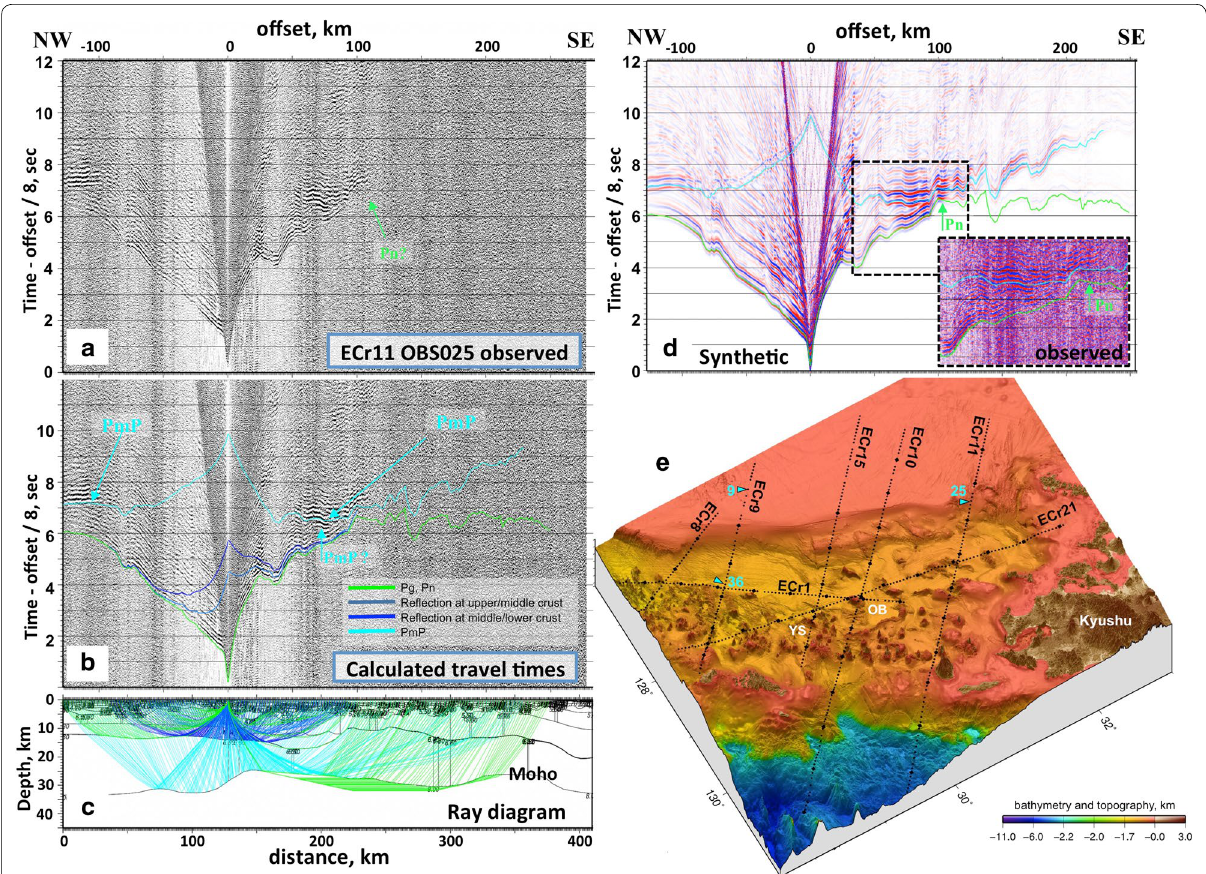
Fig. 7 Example of forward modeling for OBS025 on ECr11. a Observed record section, b calculated travel times on the record section, c ray diagram, d synthetic record sections with calculated travel times. Blowups of the observed weak Pn signals are also shown. Predictive deconvolution, 4–20 Hz bandpass filter, and a gain factor proportional to distance were used to increase signal-to-noise ratios of the observed record sections. The reduction velocity is 8.0 km/s. The color of the calculated travel times corresponds to the ray path in the ray diagram. The ray paths are generated at equal distance. e Positions of the seismic lines and ocean bottom seismographs (OBSs) on the three-dimensional topographic map. OB Okigaja Bank, YS Yokogan